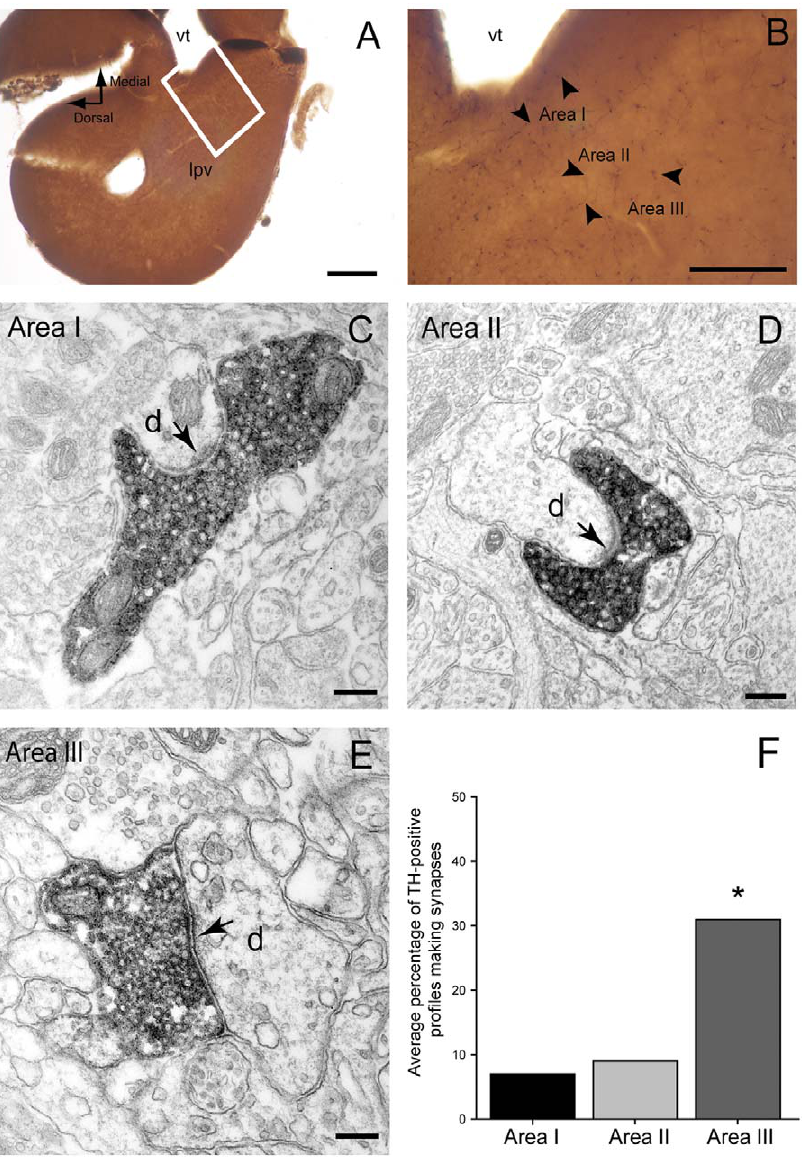
Figure 6. Tyrosine hydroxylase (TH) immunoreactivity in the lamprey striatum. A and B. Light microscope photomicrographs showing the areas (I, II and III) of the striatum that were included in the electron microscope analysis. Note the slightly higher density of TH-immunoreactive fibers (some indicated by small arrows) in Areas I and III. C–E. Electron micrographs of TH-immunolabeled axonal profiles forming asymmetrical synapses (arrows) with dendritic shafts (d) in Area I (C), II (D) and III (E) of the lamprey striatum. Note the densely packed vesicles and the prominent postsynaptic densities. F. Quantitative analysis of synaptic incidence in the three areas of striatum. The histogram shows the average percentage of TH-immunolabeled profiles which form synaptic junctions (out of a total of 75 profiles per area, n=3). Synaptic incidence in Area III was significantly higher when compared to Area I ( x 2 test, p=0.0003) and Area II ( x 2 test, p=0.0022). Abbreviations: vt, ventriculus medius telencephali; lpv, ventral part of the lateral pallium . Scale bars: A: 200 m m, B: 100 m m, C–E: 200